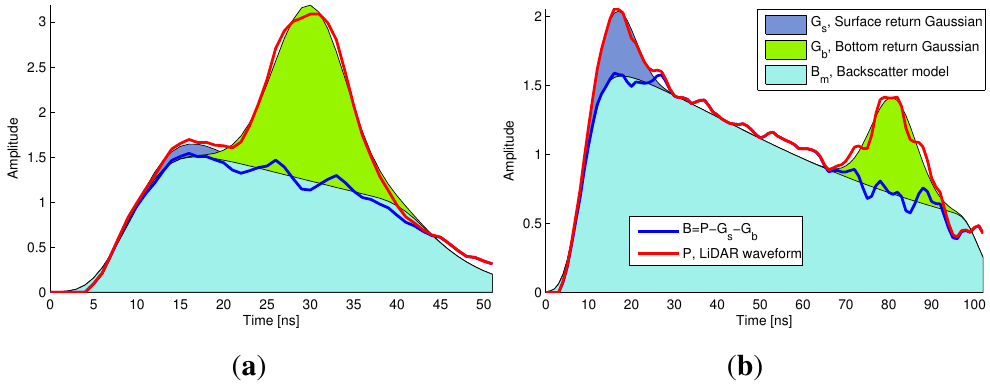
Figure 10. Shallow water ( a ) and deep water ( b ) bottom return pulse